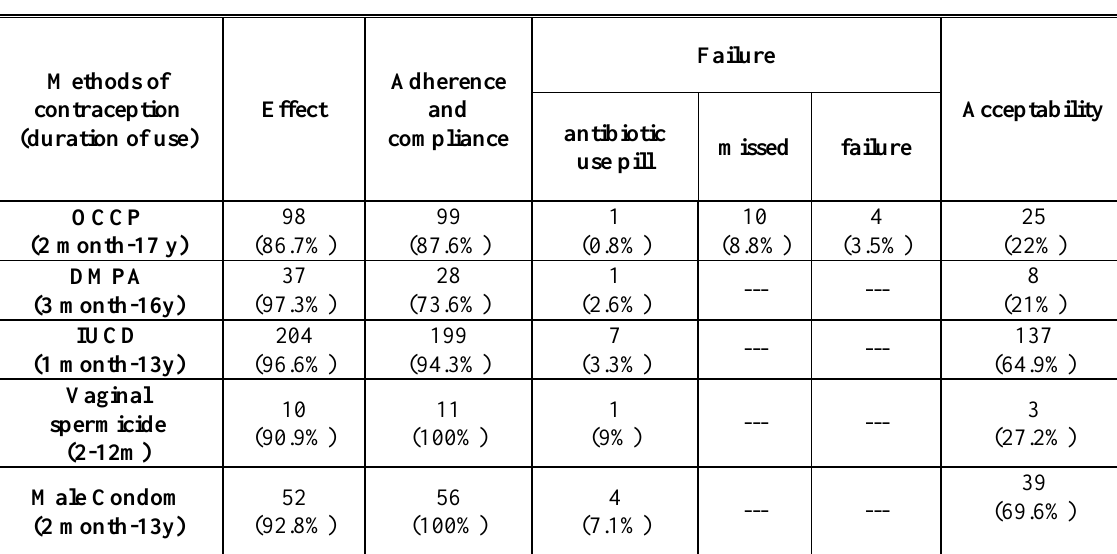
Table 1 : Number of subjects (and their percentage) used different contraceptive methods regarding effect, adherence and compliance, failure and